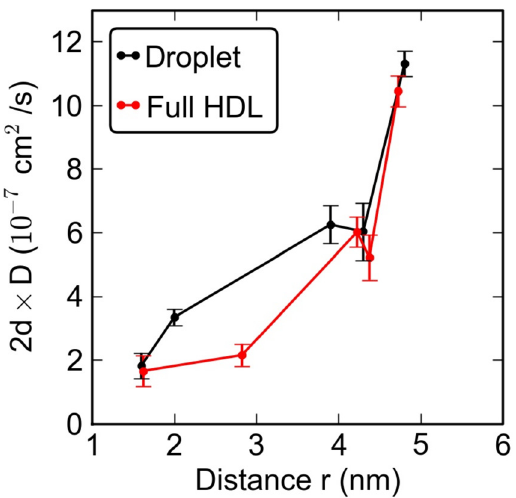
Figure 6. Diffusion coefficients of the lipid components. Each point in the plot describes the diffusion coefficient for one of the lipid types. The distance r is the average distance of the given lipid from the COM of the particle. To facilitate comparison between core (three- dimensional diffusion) and surface lipids (two-dimensional diffusion), the coefficients have been scaled with 2 d , where d is the dimension of the fit (either two or three).